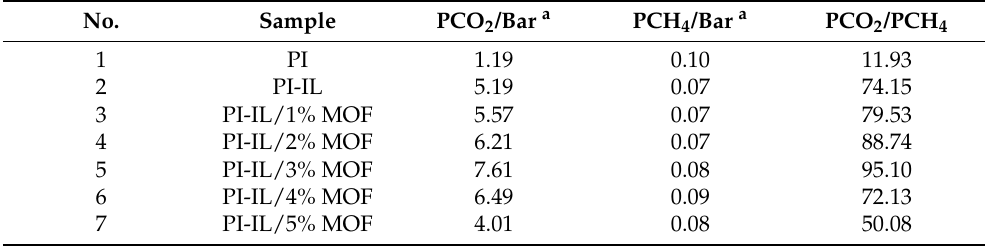
Table 3. CO 2 and CH 4 of permeability and selectivity of membranes measured at 34 ◦ C. No. Sample